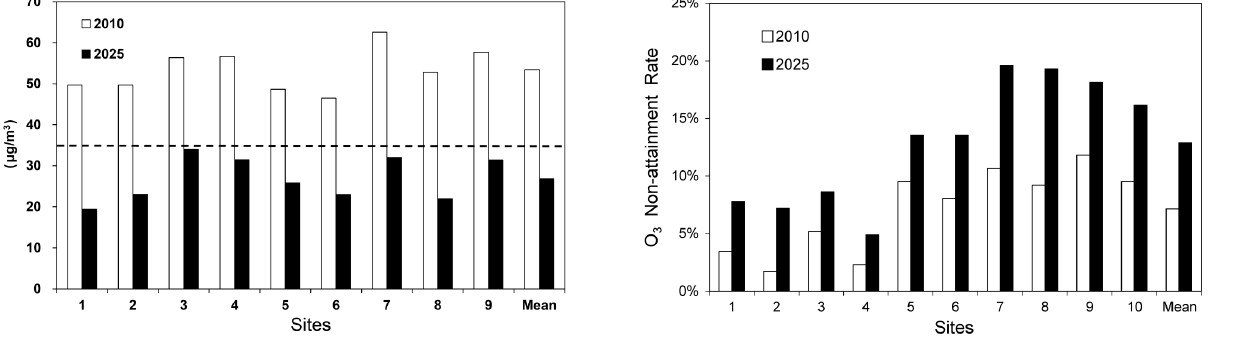
Fig. 13. Ozone non-attainment rate (by maximum 8-h average concentration) in Guangzhou, 2010 and 2025. (Sites name from 1 to 10: Guangya, 5School, Jiancezhan, Tianhu, Luhu, Guangshang, 86School, Panyu, Huadu, Jiulong)